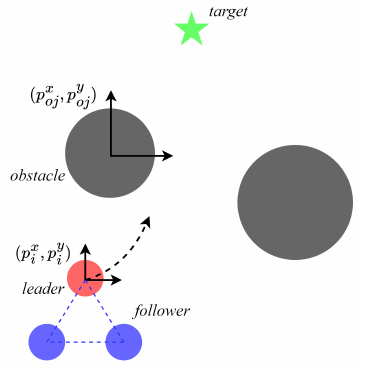
Figure 1. Multi-robot formation scene.